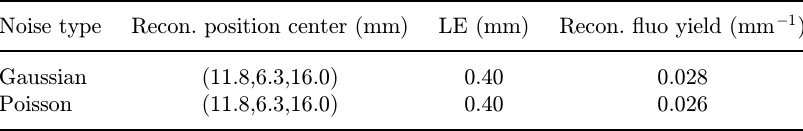
Table 5. Reconstruction results by CoSaMP with noisy measurements.